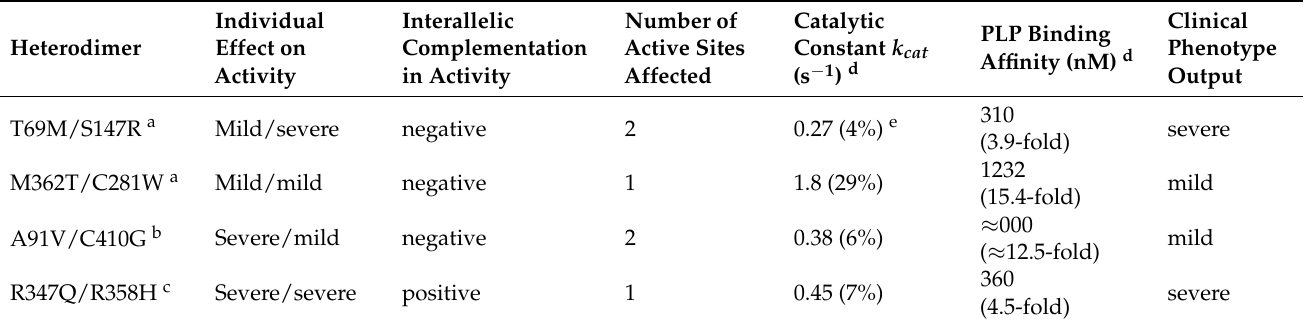
Table 1. Characteristics of the heterodimeric AADC proteins present in four compound heterozygous AADC deficiency patients.